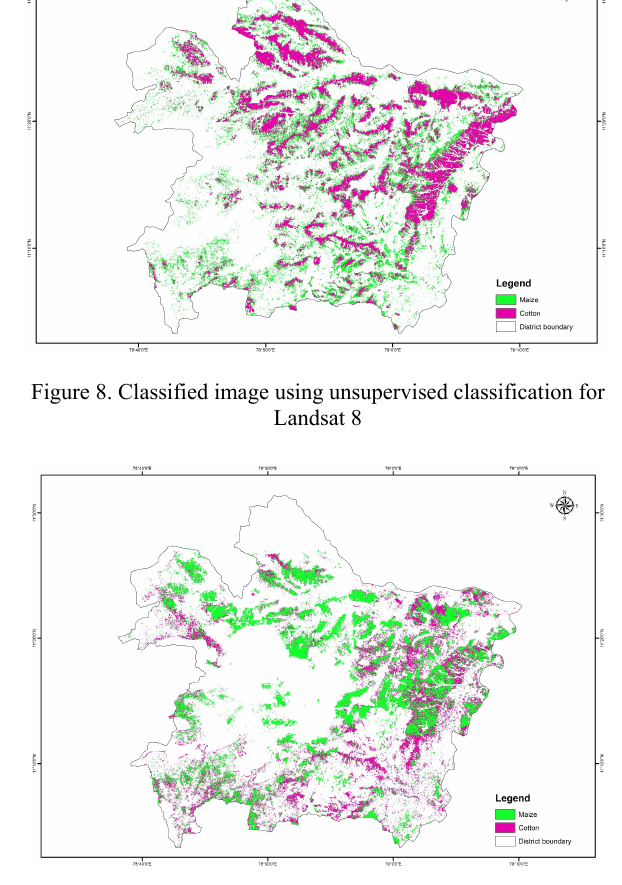
Figure 9. Classified image using unsupervised classification